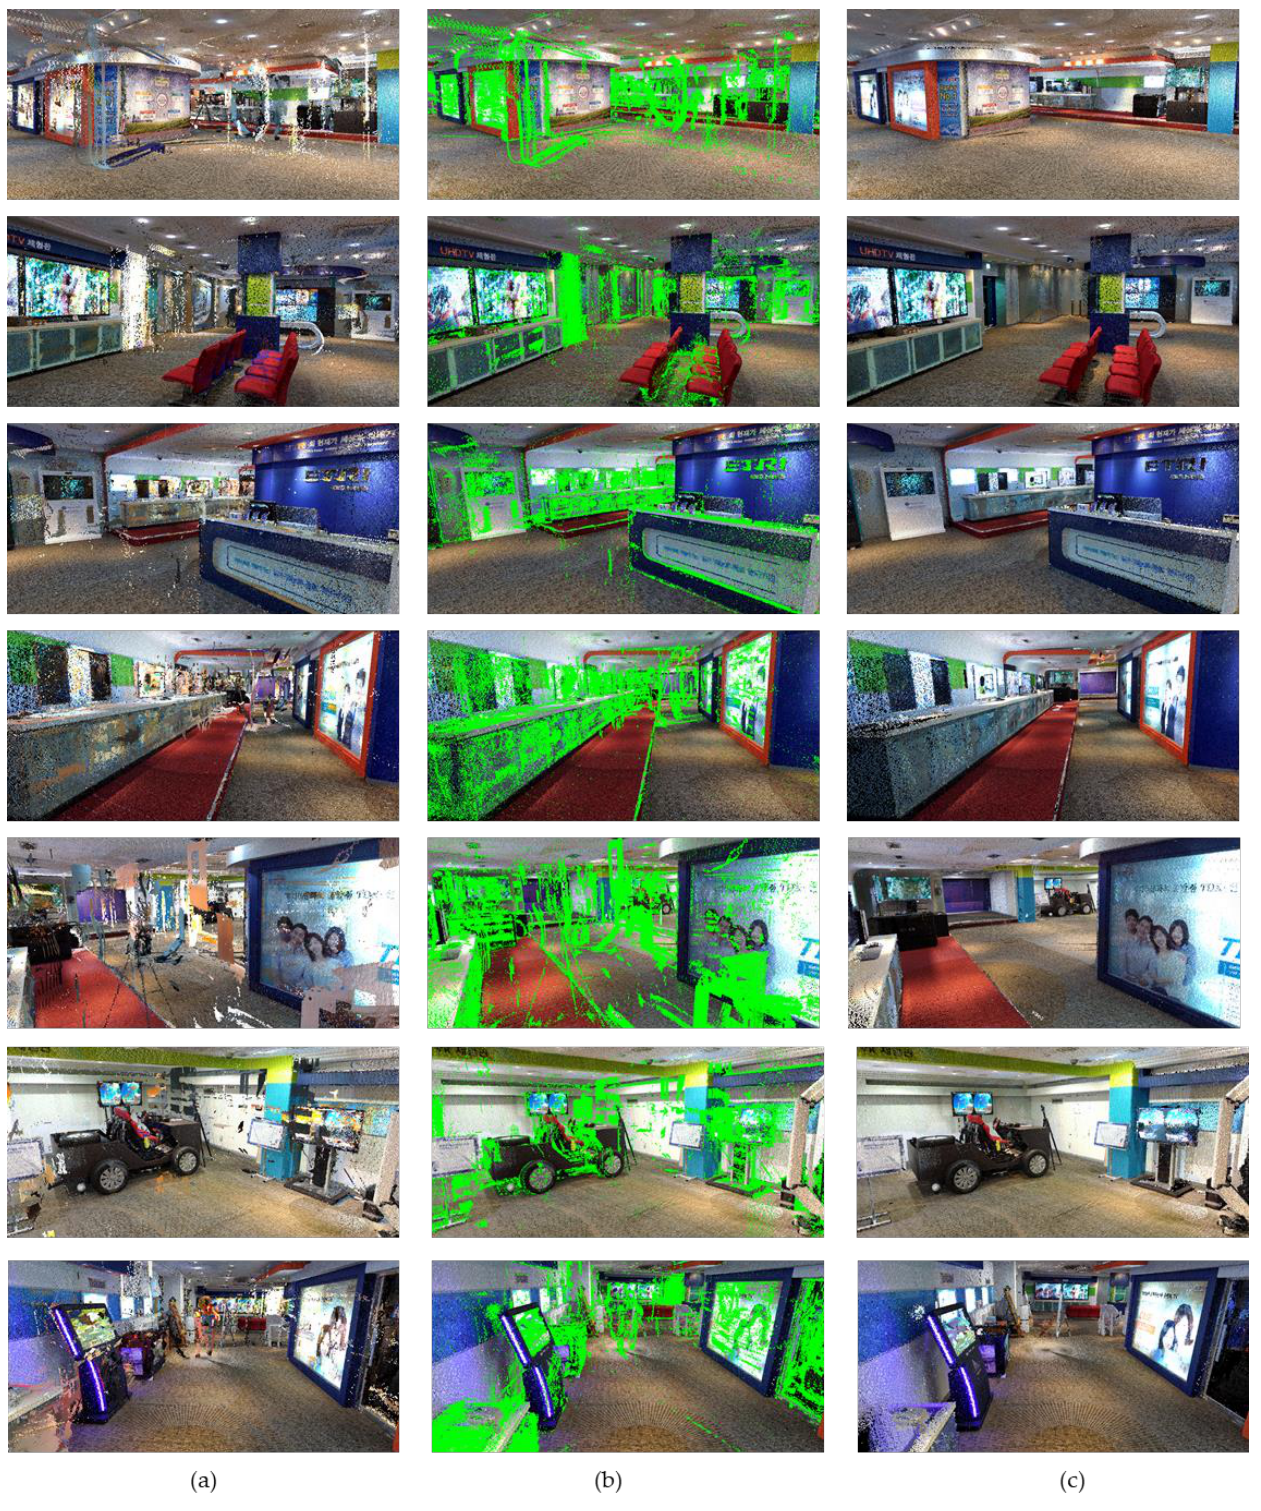
Figure 10. Results of the proposed method. ( a ) is the original point cloud, ( b ) shows the noise region detected by our method, highlighted in green, and ( c ) is the result of denoising using our method. Figure 11 shows results for other datasets from a total of 190 different locations where the point-cloud data were collected. The figure shows the results after merging all data.